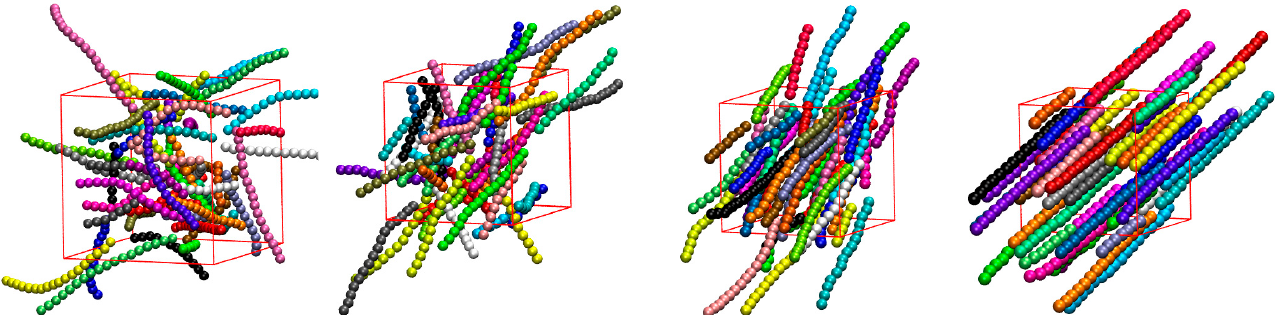
Figure 3. Snapshots of the initial configurations for the 100-chains, N av = 12, k θ = 9, θ 0 = 0 ◦ system showing at increasing packing densities. From left to right: ϕ = 0.10, 0.20, 0.30, and 0.50. Monomers are colored according to the parent chain. For clarity, only 50 chains (half of the total population) are shown. Chains are shown with the coordinates being fully unwrapped in space. Images created with VMD visualization software [141]. Individual panels are also available as stand-alone, interactive, 3-D images (in Supplementary Materials).